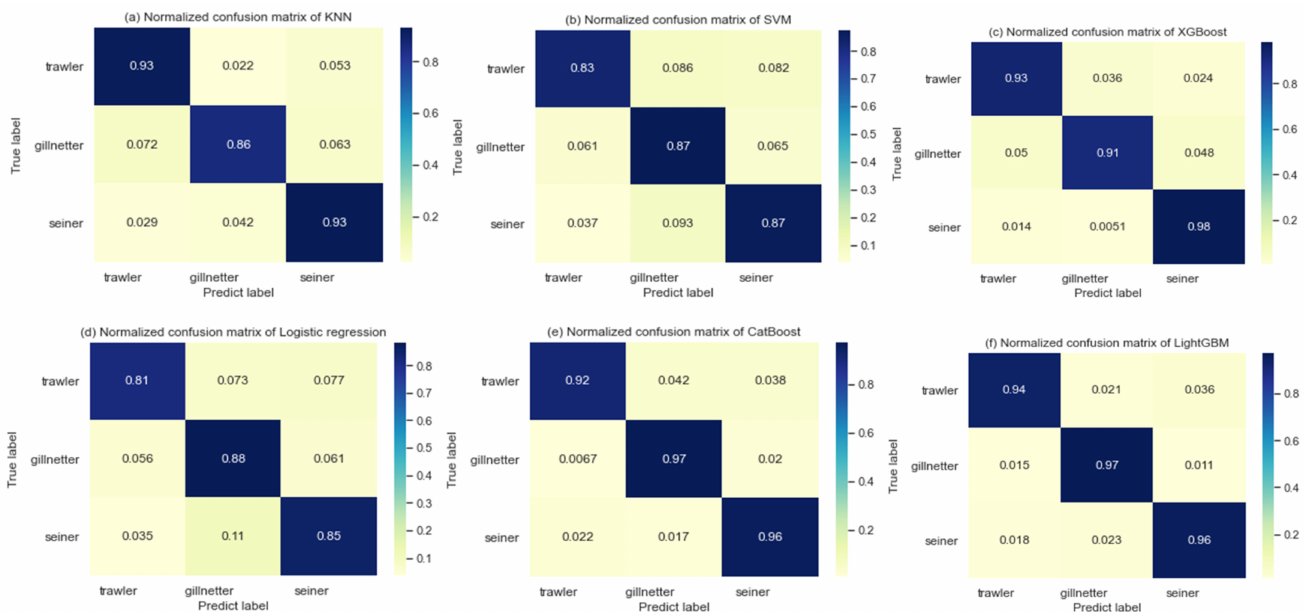
Figure 9. Normalized confusion matrices of classification for trawlers, gillnetters and seiners obtained by the different classifiers. The five classifiers are ( a ) KNN, ( b ) SVM, ( c ) XGBoost, ( d ) Logistic regression, ( e ) CatBoost and ( f ) LightGBM.